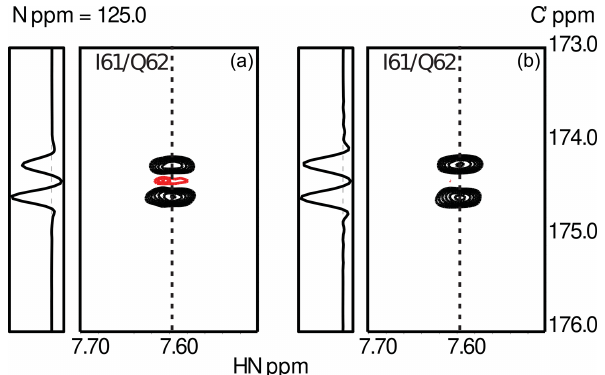
Figure 3. Experimental results from the measurements of trans- verse (a) and longitudinal (b) 13 C (cid:48) / 13 C (cid:48) 13 C α CSA-DD CCR as described in Sect. 3. Data were obtained using ubiquitin, a small globular protein of 76 residues. The figure shows the spectral region for the peptide plane spanning residues I61/Q62. The asymmetry of the 13 C α doublet is visible in the cross-sections taken at the posi- tions indicated by dashed lines. As expected, CCR effects are more pronounced in the case of transverse